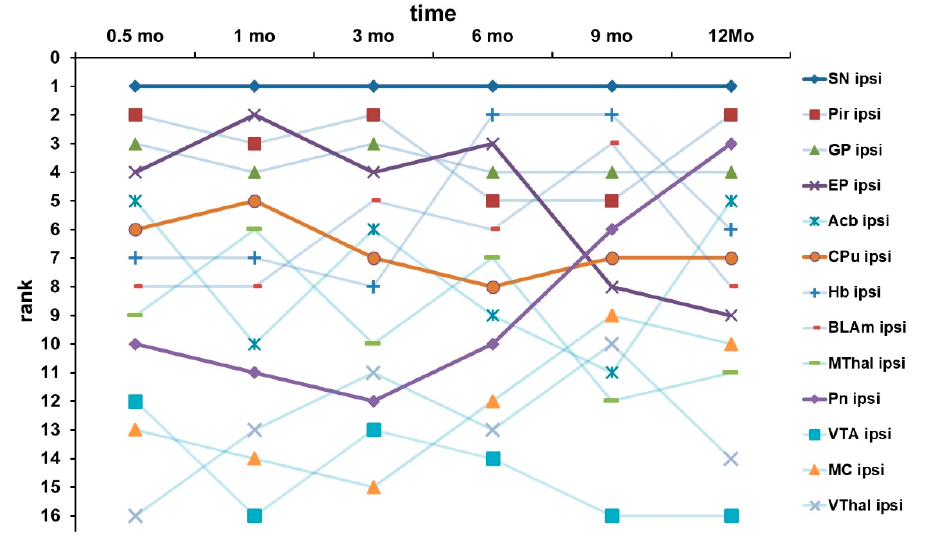
Figure 12. The diagram shows the ranking in terms of OD of selected brain areas examined